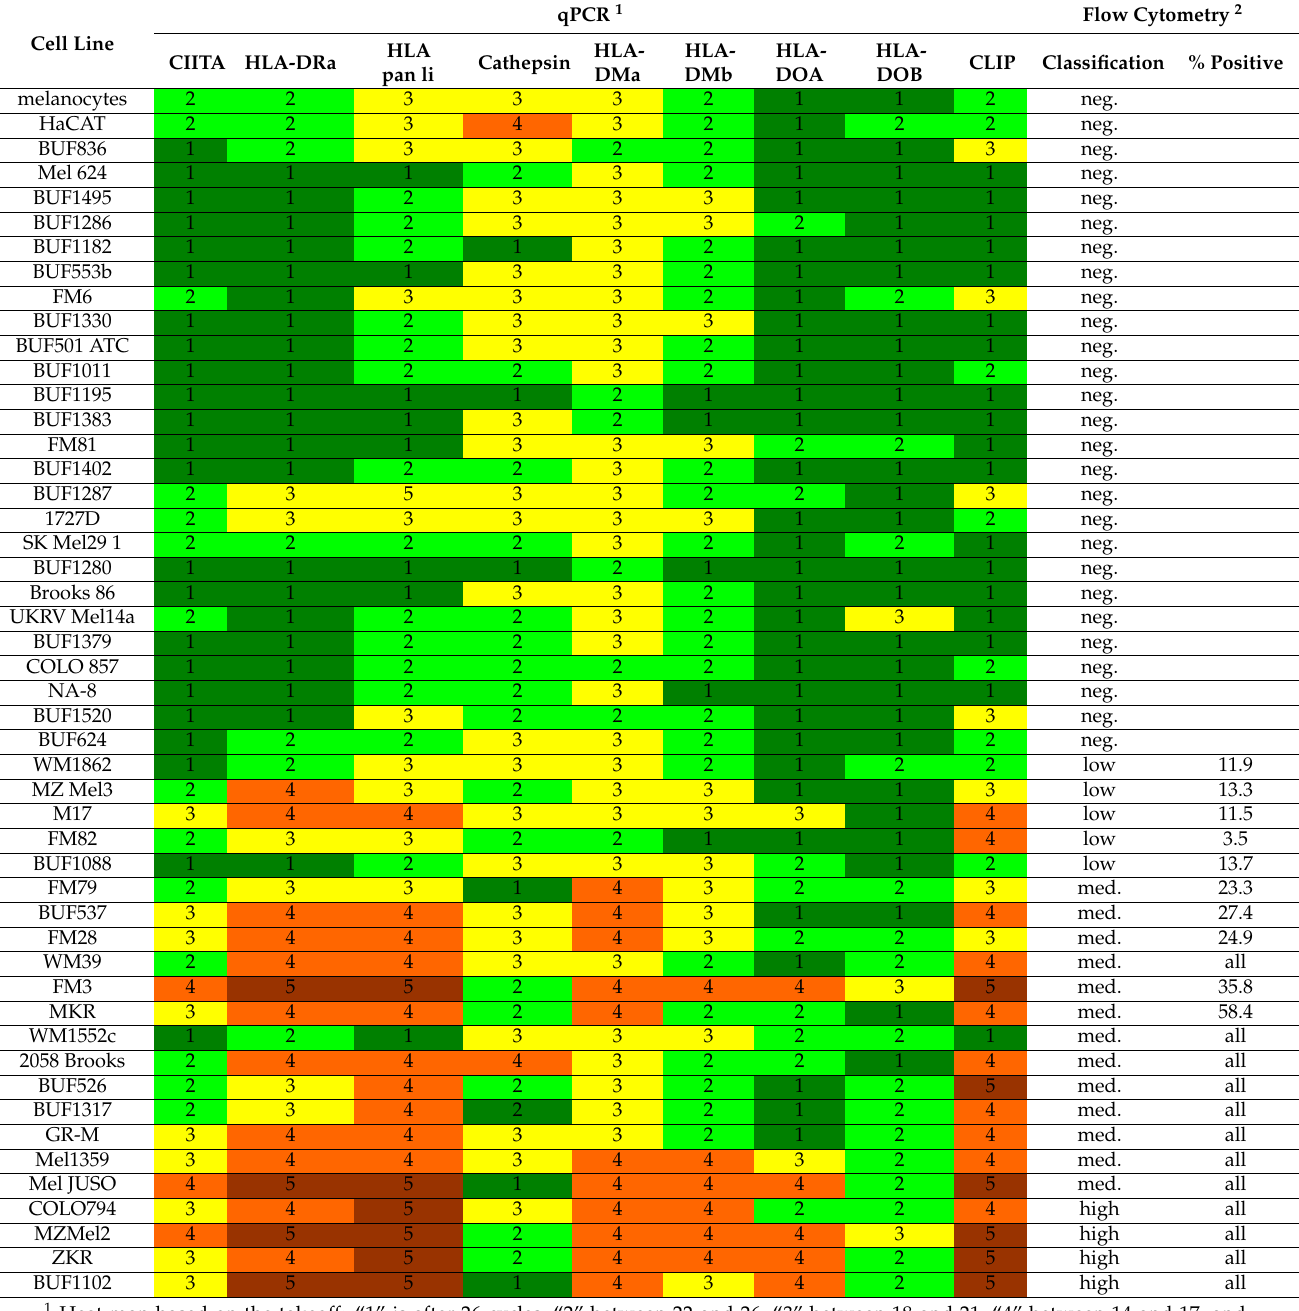
low/medium to high expression levels, while 25/47 melanoma cell lines lacked HLA class II surface expression. This led to the categorization of melanoma cell lines into negative, low/medium and high expressors (Tables 1 and 2). Table 2. Characterization of the HLA class II APM component expression in melanoma cell lines. Cell